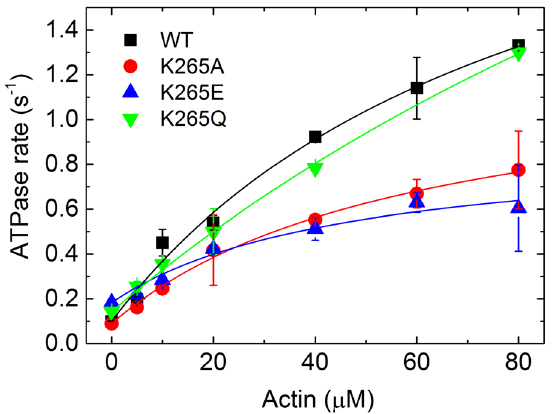
Figure 4. Steady-state ATPase activity of WT and mutant constructs. Determination of the ATPase activity for the WT and the three mutants from 0 to 80 µ M F-actin. Data are mean values of 3–6 independent measurements and error bars are the standard deviation. Constants derived from this experiment are summarized in Table 1.